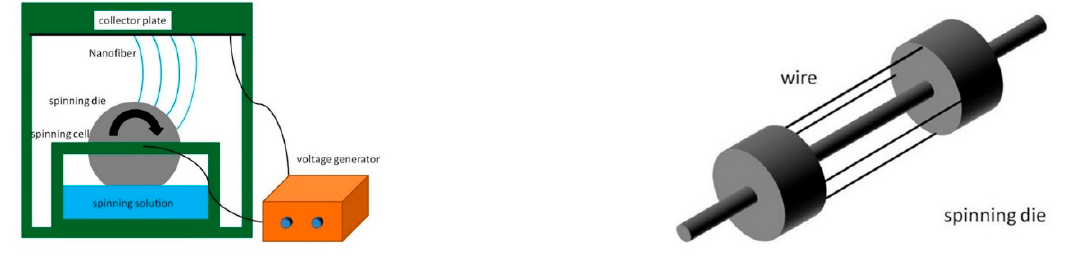
Figure 1. Configuration of the electrospinning assembly.